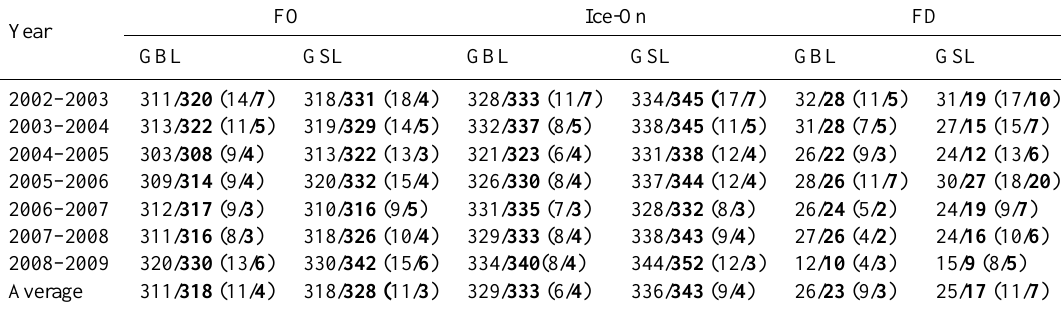
Table 3. Summary of ice phenology variables during the freeze-up period (average day of freeze-onset (FO) and ice-on, and number of days of freeze duration (FD)) for GBL and GSL (2002–2009). Values within confidence regions in bold. Standard deviation in parentheses. Year